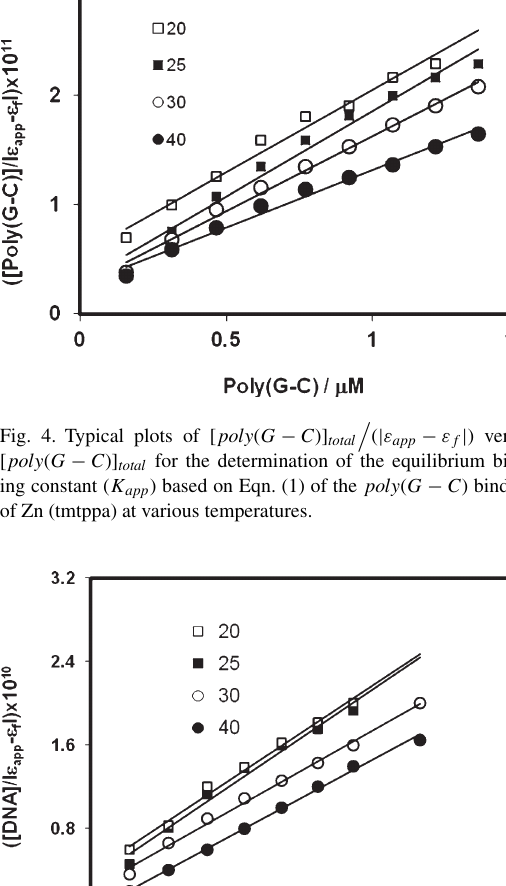
Fig.5. Typicalplotsof[ DNA ]